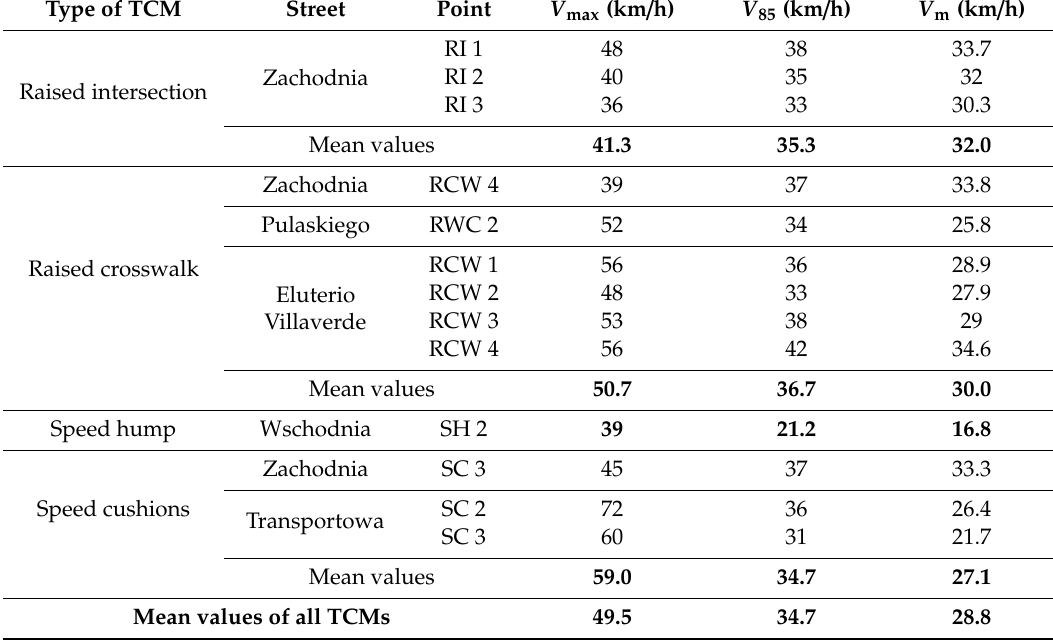
Table 2. Summary of obtained speed values at the tra ffi c calming measures.